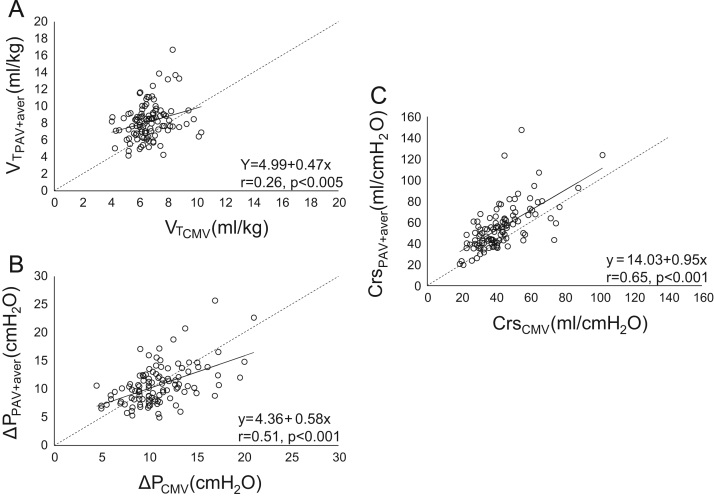
Individual relationships (all patients) between respiratory variables (VT, Crs and ΔP) during PAV+ (average data) and CMV (VTCMV CrsCMV ΔPCMV, respectively). Relationships between VTPAV+aver and VTCMV (A), ΔPPAV+aver and ΔPCMV (B), and CrsPAV+aver and CrsCMV (C). Continuous lines; regression lines. Dashed line; lines of identity. Significant linear relationships were observed between VTCMV and VTPAV+aver, ΔPCMV and ΔPPAV+aver, and CrsCMV and CrsPAV+aver. In a given plot each patient was characterized by a single data point.